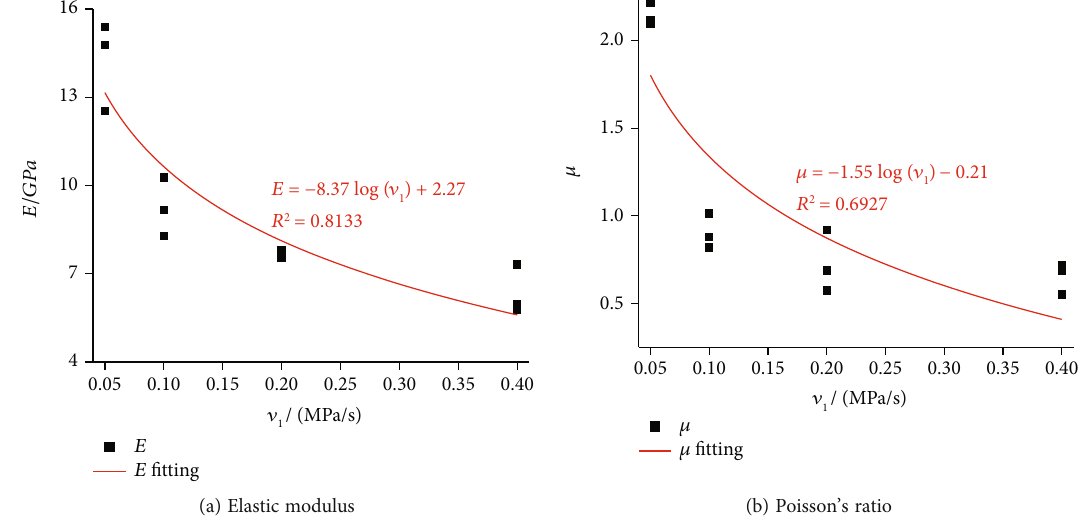
Figure 7: The relationship between deformation parameters and loading axial pressure